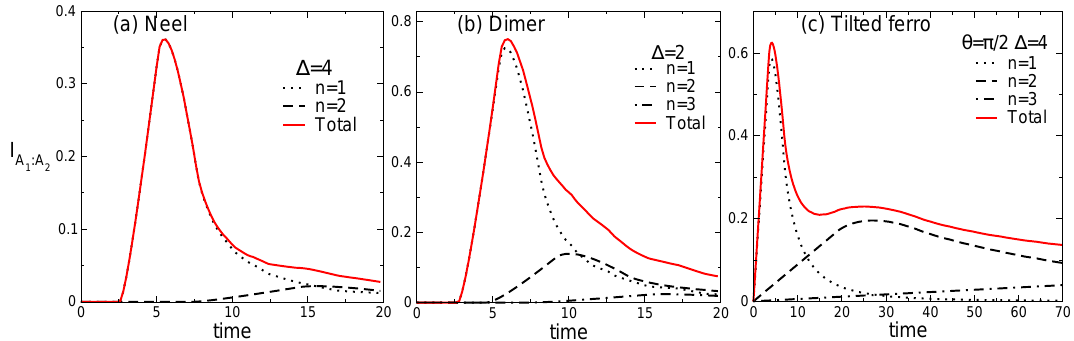
Figure 9: Post-quench dynamics of the mutual information I between two intervals A A 1 : A 2 1 and A after a quench in the XXZ chain. Panel (a) shows I for the quench from the Néel A 1 : A 2 2 state for ∆ = 4. Here A and A are two disjoint intervals of equal length (cid:96) = 10 at distance 1 2 d = 10 in units of the lattice spacing. Different curves correspond to the contributions of bound states of different size n . The continuous (red) line is obtained by summing over all the bound states. Panel (b) is the same as in (a) for the quench from the Majumdar-Ghosh state for the XXZ chain with ∆ = 2. Panel (c). Post-quench dynamics of I for the quench A 1 : A 2 from the tilted ferromagnet in the XXZ chain with ∆ = 4. Here A and A are two equal-length 1 2 intervals with (cid:96) = 10 at distance d = 0. Note the second peak at t ≈ 30 resulting from the contribution of the two-particle bound